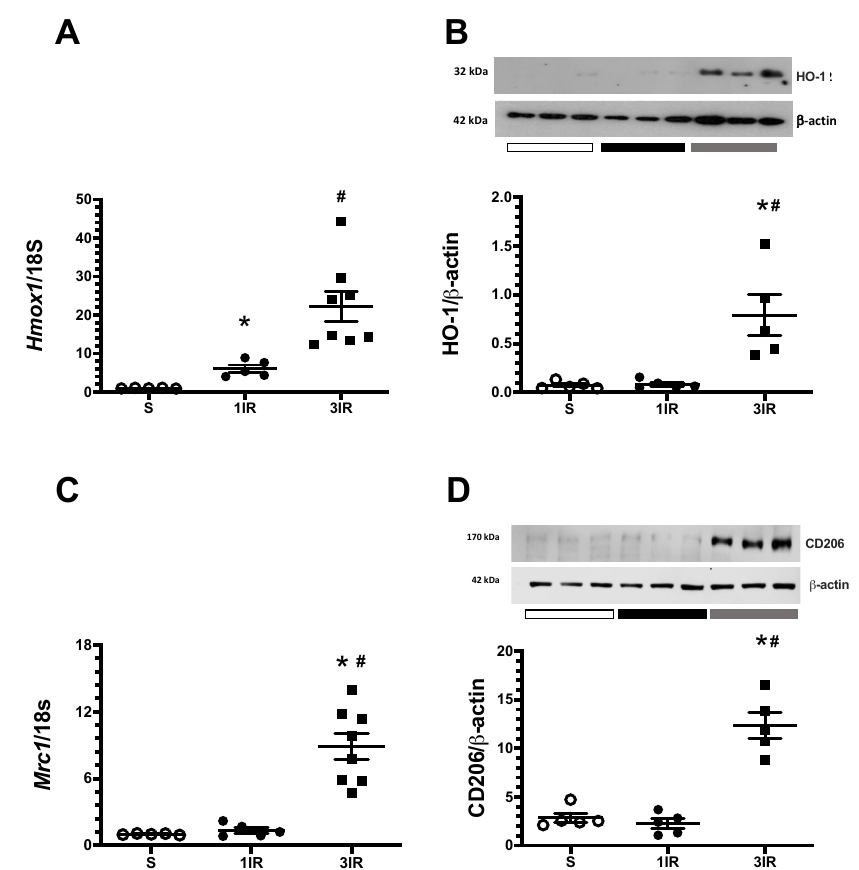
Figure 7. The renoprotective effect provoked by repeated AKI episodes was mediated by the induction of HO-1 and CD206 expression. ( A ) Hmox1 mRNA levels, ( B ) HO-1 protein expression, ( C ) Mrc1 mRNA levels and ( D ) CD206 protein expression, 24 h later that the last IR episode. The sham group is represented in white circles, the 1IR group in black circles, and the 3IR group in black squares. * p < 0.05 vs. S; # p < 0.05 vs. 1IR